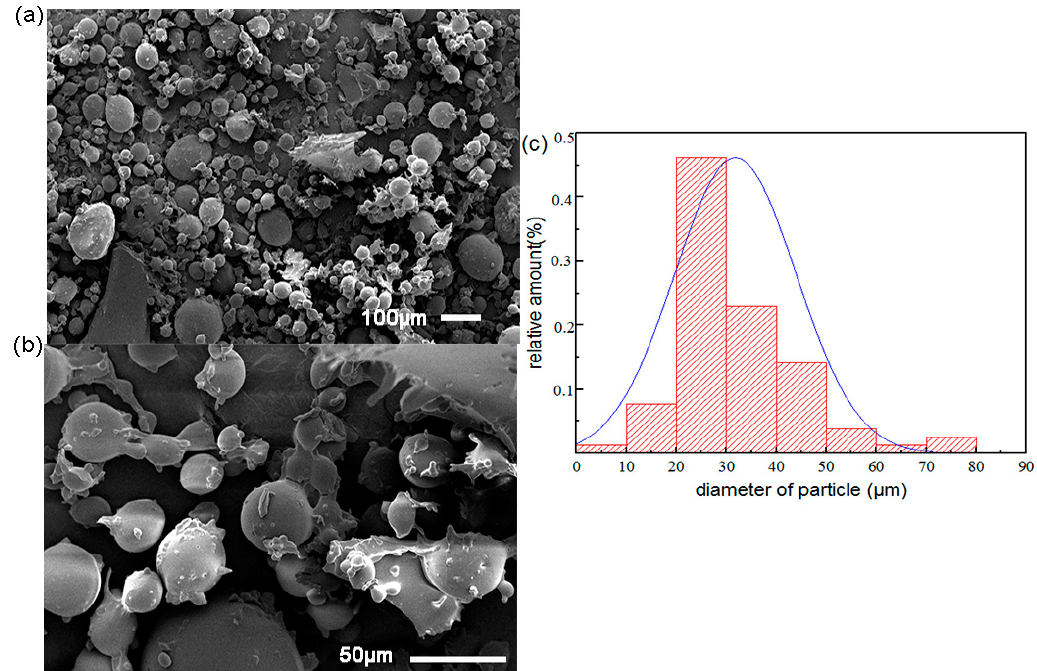
Figure 2. Scanning Electron Microscopy (SEM) analysis of modified chitosan microspheres and their size distribution. ( a ) SEM analysis of modified chitosan microspheres (the scale bar is 100 µ m). ( b ) SEM analysis of modified chitosan microspheres (the scale bar is 50 µ m). ( c ) Diameter distribution of modified chitosan microspheres.